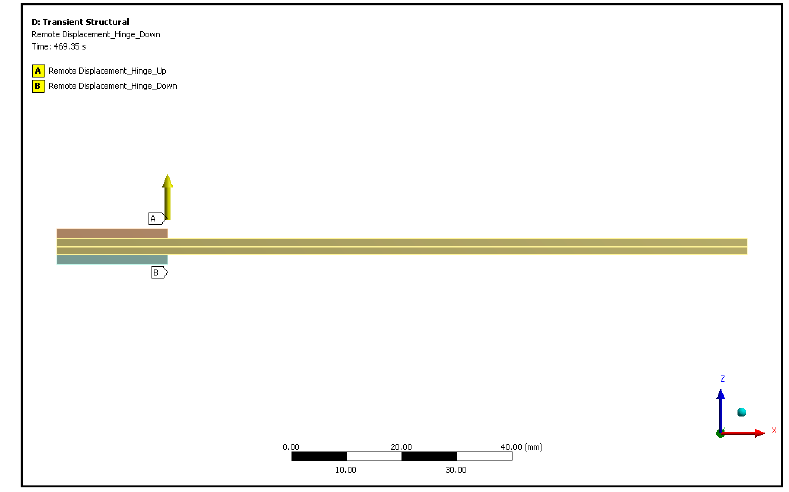
Figure 5. Applied load in the numerical model of the double cantilever beam (DCB) delamination tests.